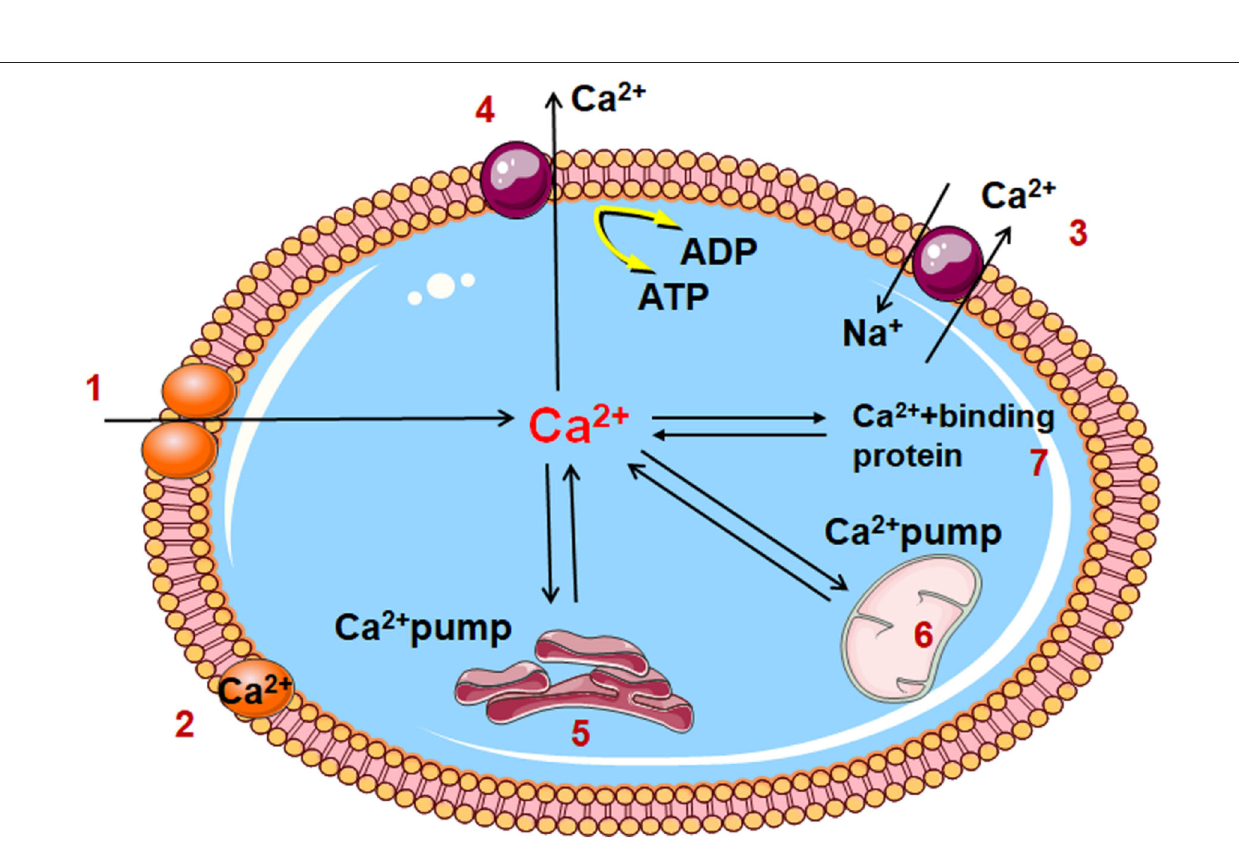
Frontiers in Cardiovascular Medicine | www.frontiersin.org